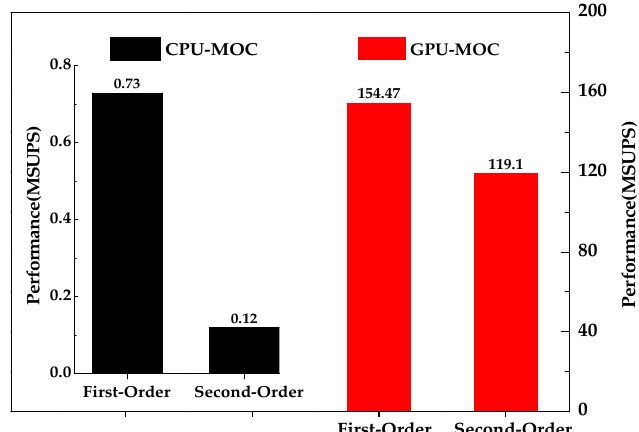
Figure 9. Performances of GPU-MOC and CPU-MOC for the two interpolation methods.